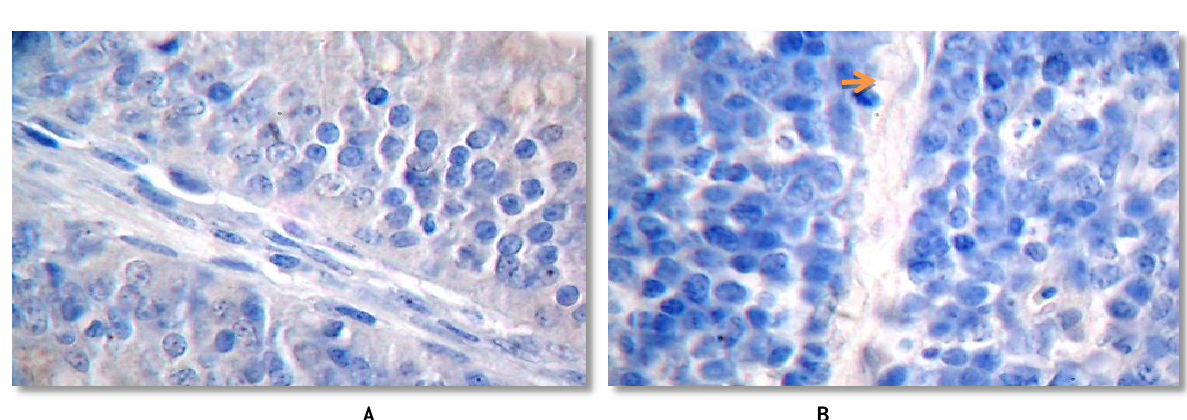
A B Figure,2: Macrophages in paraffin embedded sections (5µm) were identified by using an anti-chicken monocyte- macrophage mouse monoclonal antibody (KUL01) and an HRP –conjugated secondary antibody A: Macrophages in the duodenum of a heat stressed β-glucan treated 14 days old chick G1. Immunopositive cells are purple-brown ( ) .B: Macrophages in the bursa of fabricius of a heat stressed β -glucan treated 14 days old chick G1. Immunopositive cells are purple-brown ( ) .100 x.